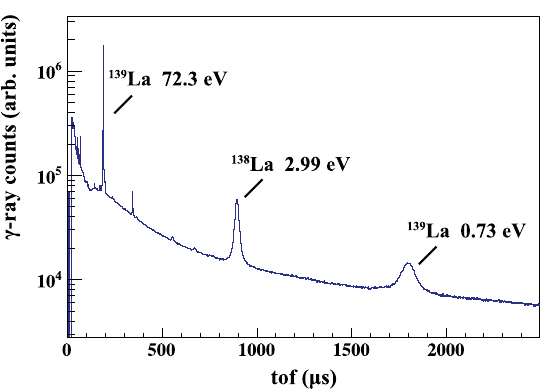
Figure 3. Neutron time-of-flight (TOF) spectrum measured with the lanthanum